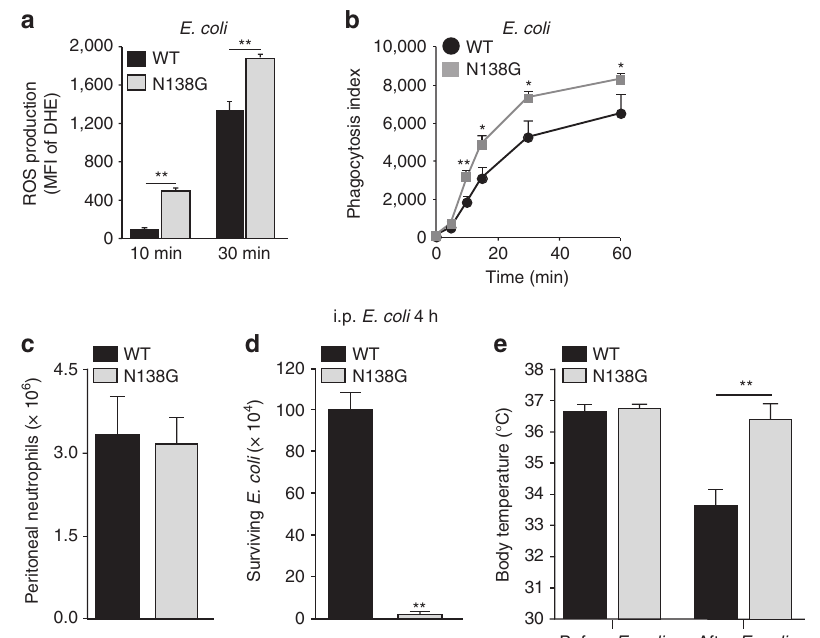
Figure 5 | Primed neutrophils from N138G mice have enhanced bacterial killing in vitro and in vivo . ( a ) ROS generated by neutrophils in heparinized blood after incubation with E. coli for 10 or 30min. ( b ) Phagocytosis of fluorescent E. coli by neutrophils in heparinized blood. ( c , d ) Number of neutrophils and bacteria recovered by peritoneal lavage 4h after intraperitoneal injection of E. coli . ( e ) Body temperatures of mice before and 4h after intraperitoneal injection of E. coli . Data in a and b are mean ± s.e.m. of four experiments with three mice per group. Data in c – e are mean ± s.e.m. of ten mice per